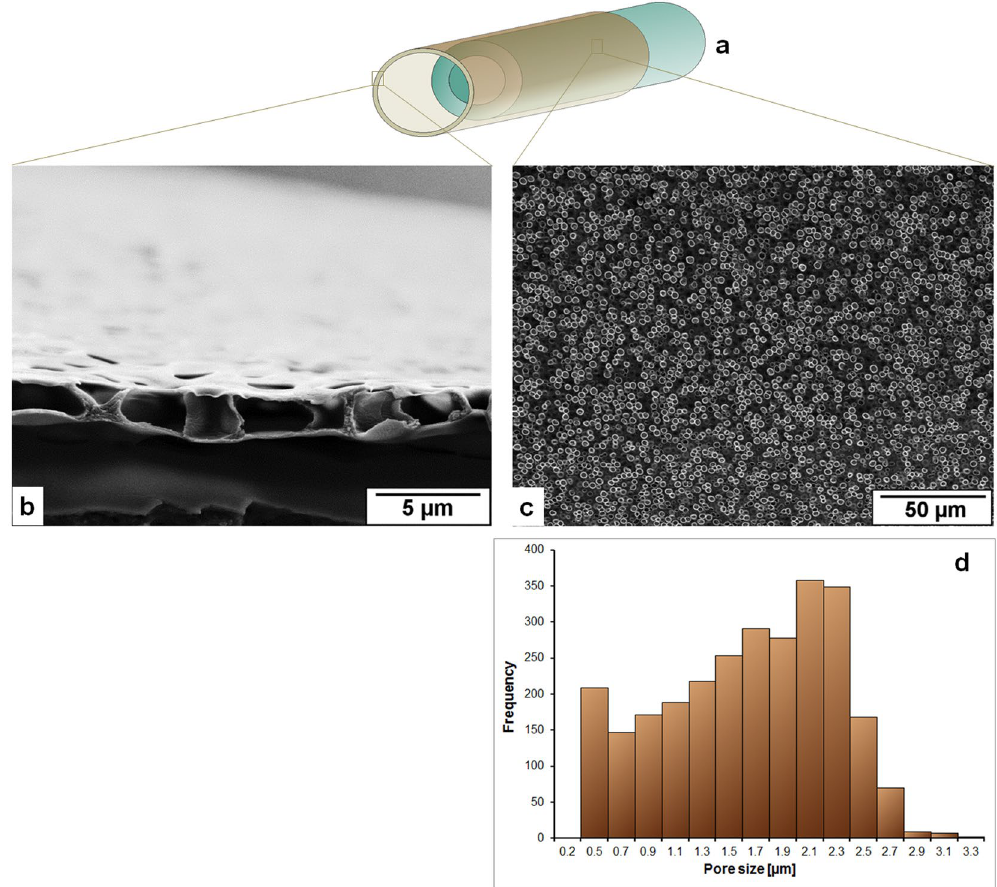
Figure 2. Film forming solution: 8% CA in 1,4-dioxane (Group 1 in Table 1); ( a ) A schematically drawn hollow fiber where the macroporous outer layer film encircles the support layer hollow fiber, ( b ) Cross sectional view of the porous film under scanning electron microscope (SEM), ( c ) Surface of the film under SEM, ( d ) pore size distribution [2724 number of pores in 39.54 × 10 3 µ m 2 of the measured area] of the surface of the film forming layer measured by IMS V15Q4 (Imagic Bildverarbeitung AG, Glattbrugg,